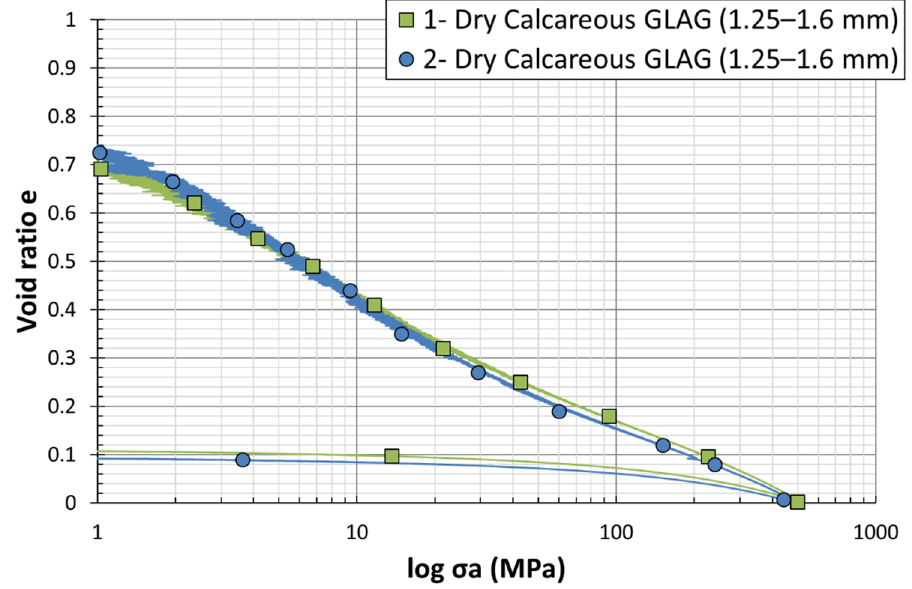
Figure 11. Load–settlement curves from dry oedometer tests on Calcareous sand grains of similar sizes ( D 50 = 1.425 mm).